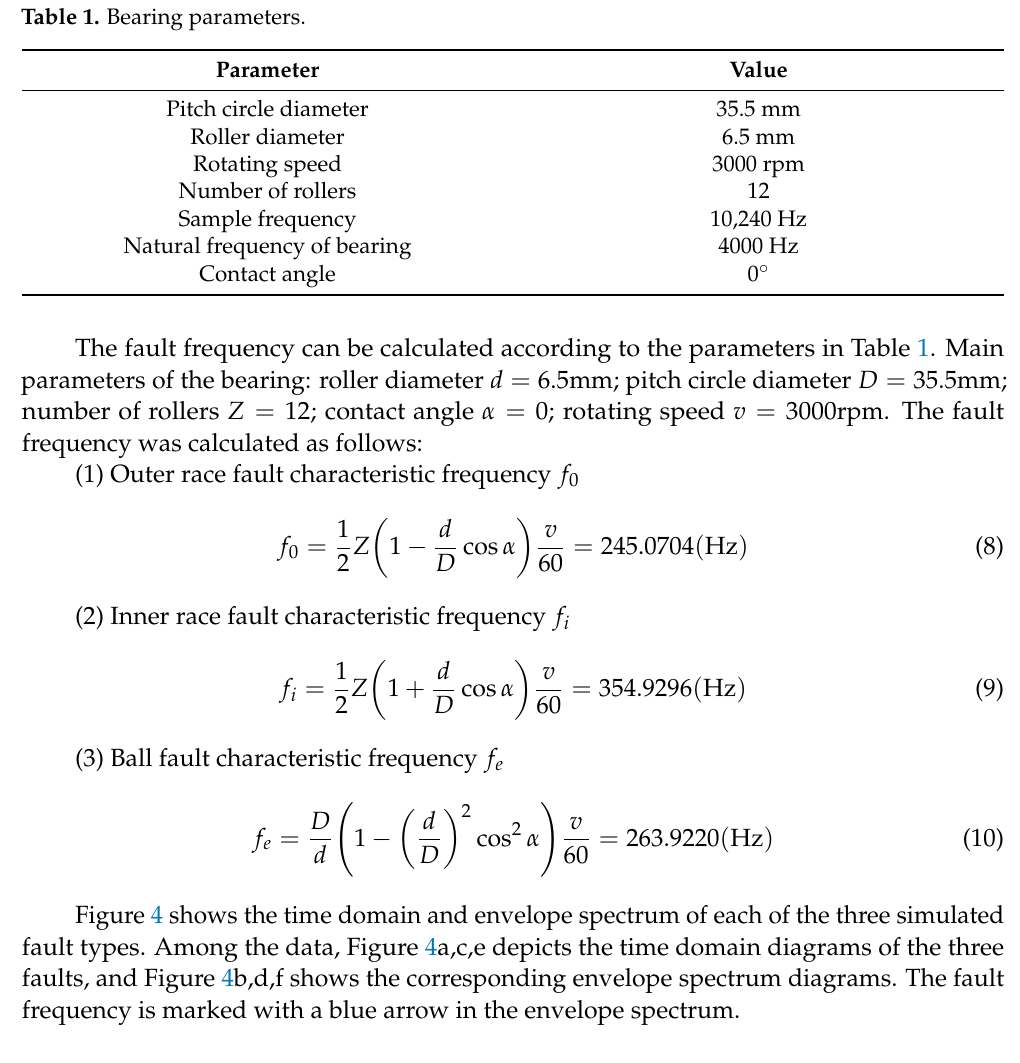
Figure 3. The schematic of simulated bearing faults.